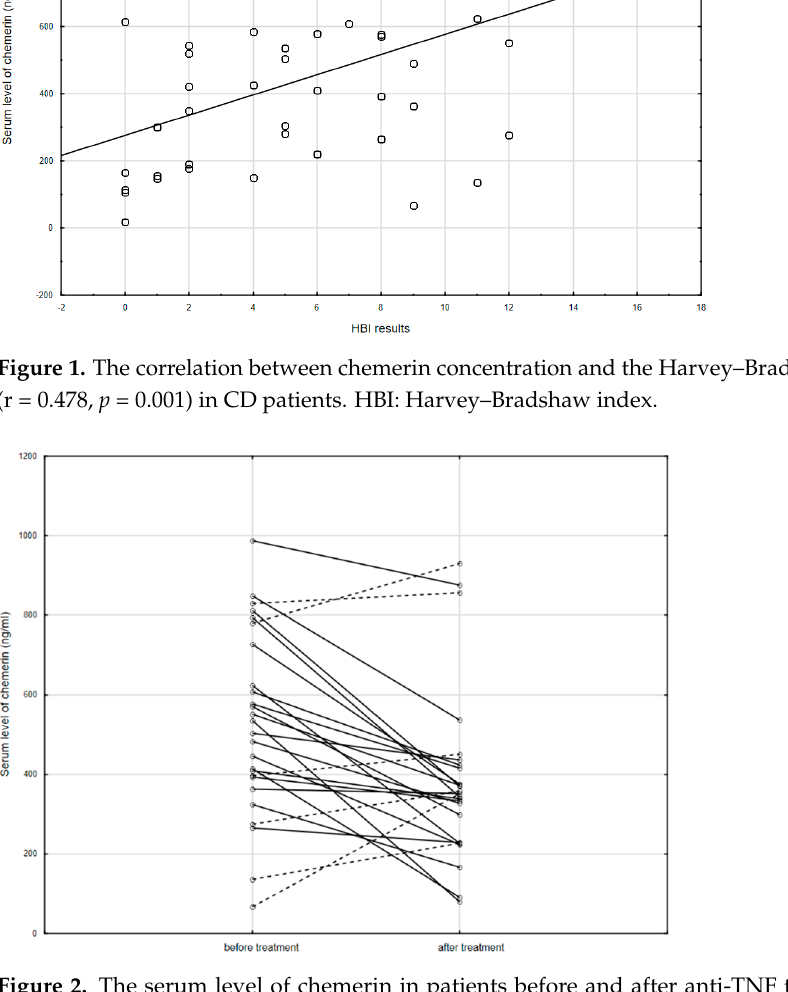
Figure 2. The serum level of chemerin in patients before and after anti-TNF therapy. Solid line: de- creased concentration; dashed line: increased concentration. decreased concentration; dashed line: increased concentration. Table 2. Relationship between the selected clinical parameters and the concentration of chemerin in the IBD patients’ blood